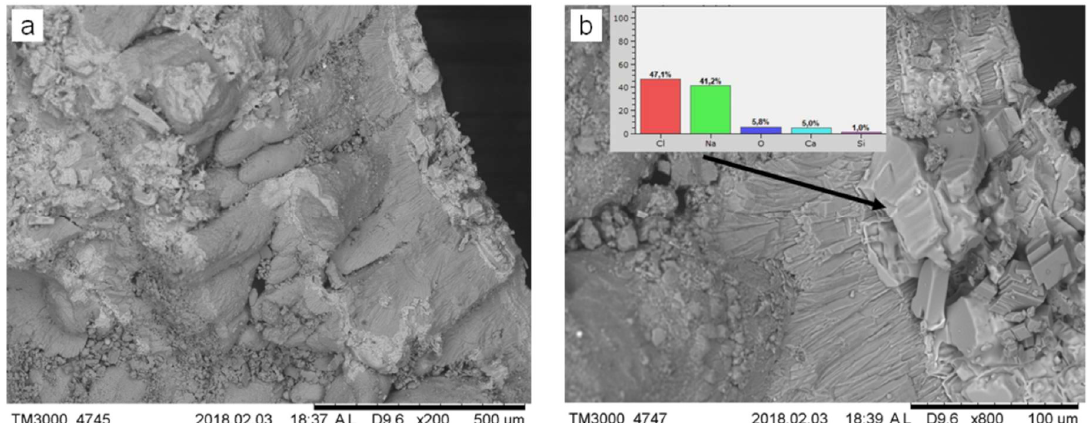
Figure 6. Salt precipitations on the surface of crust developing at the upper level of the embankment: ( a ) general view; and ( b ) EDS spectra.